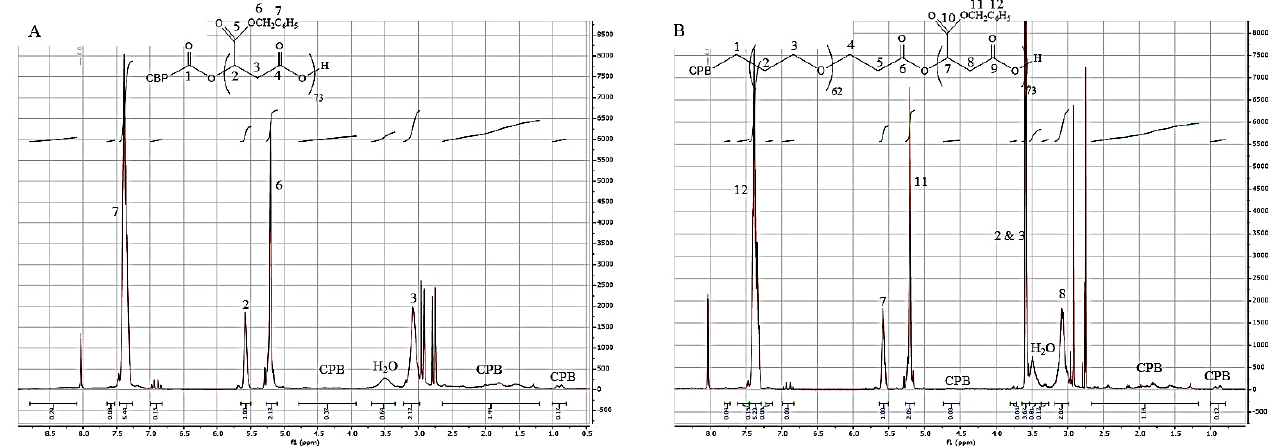
Figure 5. 1 H NMR spectrum of: ( A ). CPBPMLABe 73, and ( B ). CPBPEG 62 - b -PMLABe 73 .